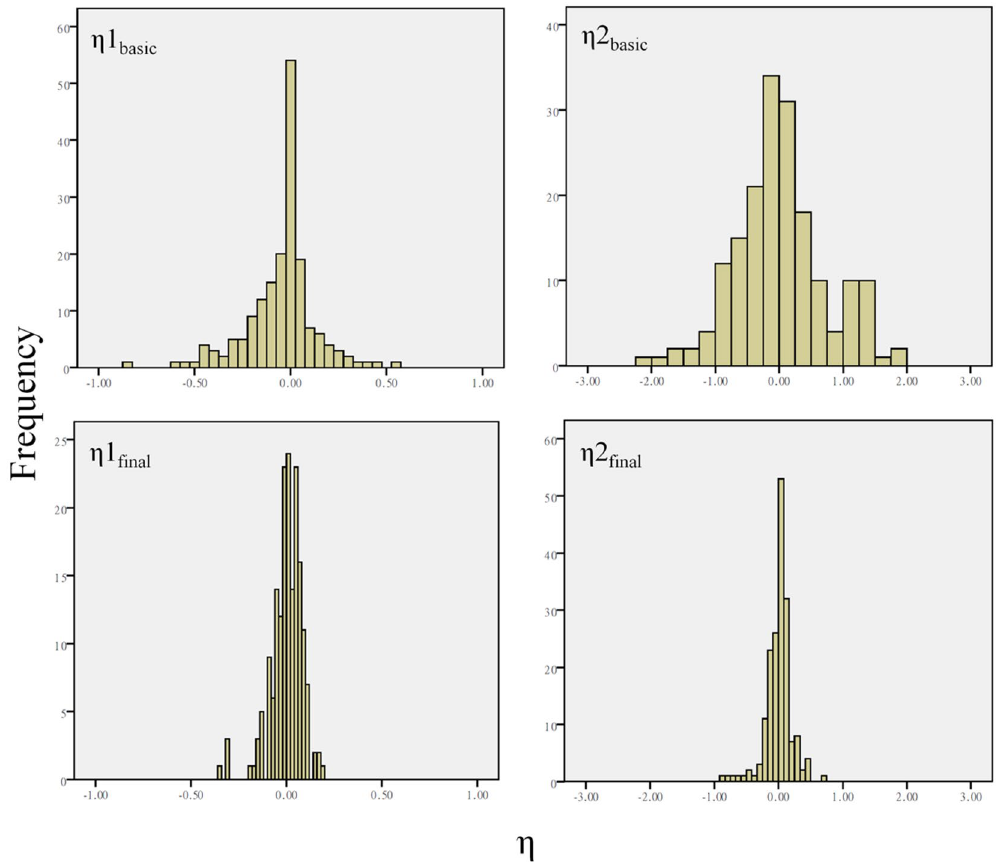
Figure 4. Distribution of η 1 (IIV for CL) and η 2 (IIV for V) for basic and final population models.